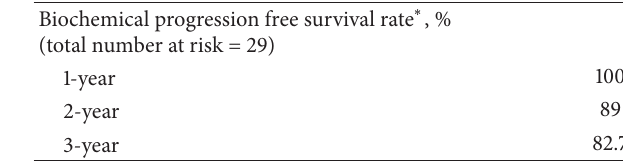
Table 4: Actuarial biochemical